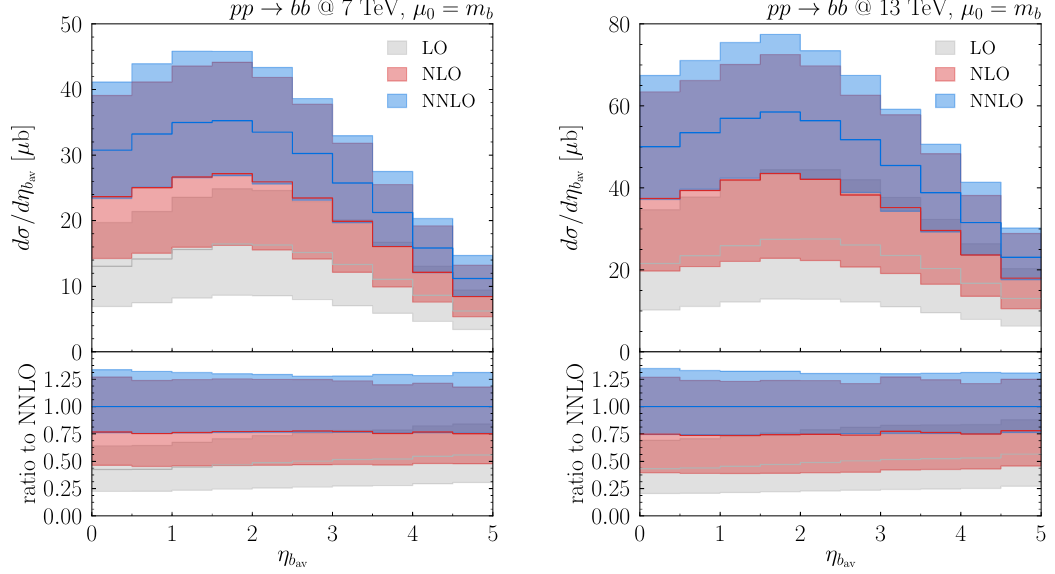
Figure 6 . Pseudorapidity distribution of the bottom quark at the LHC for p s = 7 TeV (left) and 13 TeV (right). The lower panels show the ratio to the NNLO